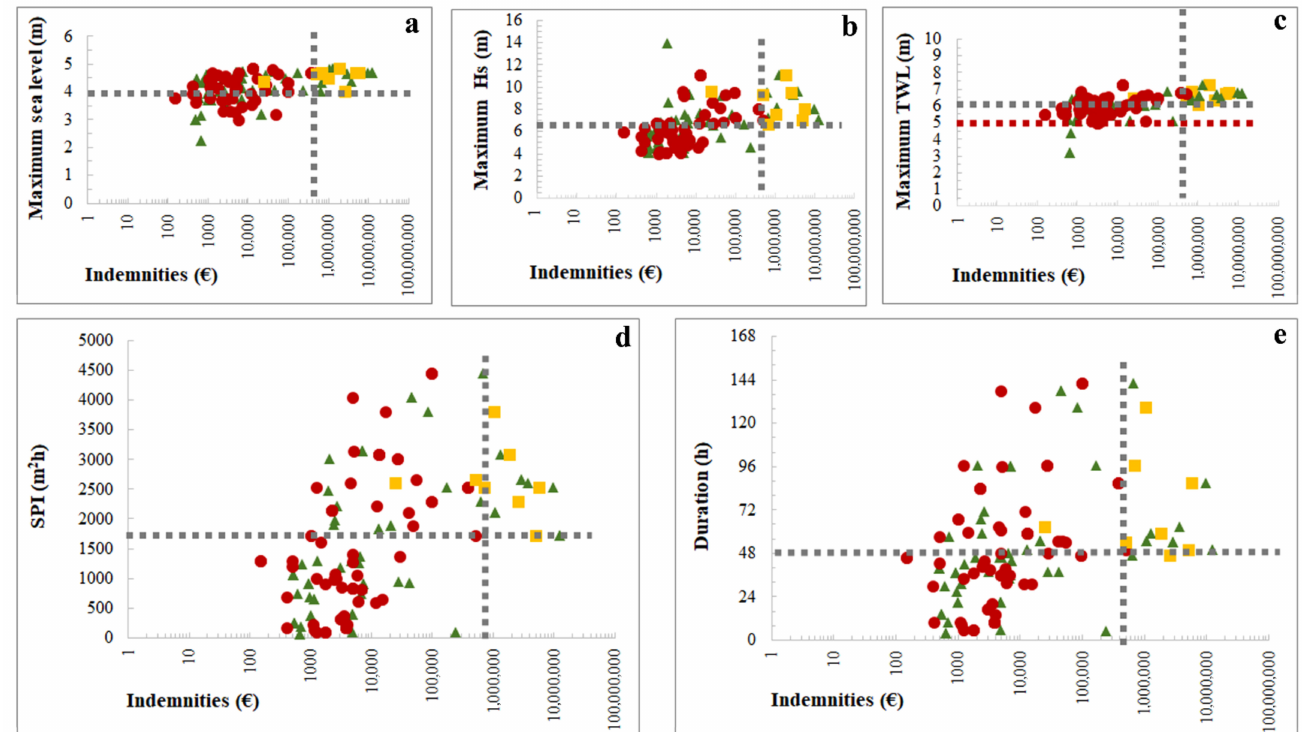
Figure 10. Thresholds for various hydrodynamic indicators based on the amount and type of damage on the eastern Cantabrian coast. Buildings: green triangles; Vehicles: red circles; Infrastructures: yellow squares. Dotted grey lines: thresholds for infrastructure. Dotted red line: threshold for vehicles. ( a ) Maximum sea level; ( b ) Maximum wave height; ( c ) Maximum total water level; ( d ) Storm Power Index; ( e )